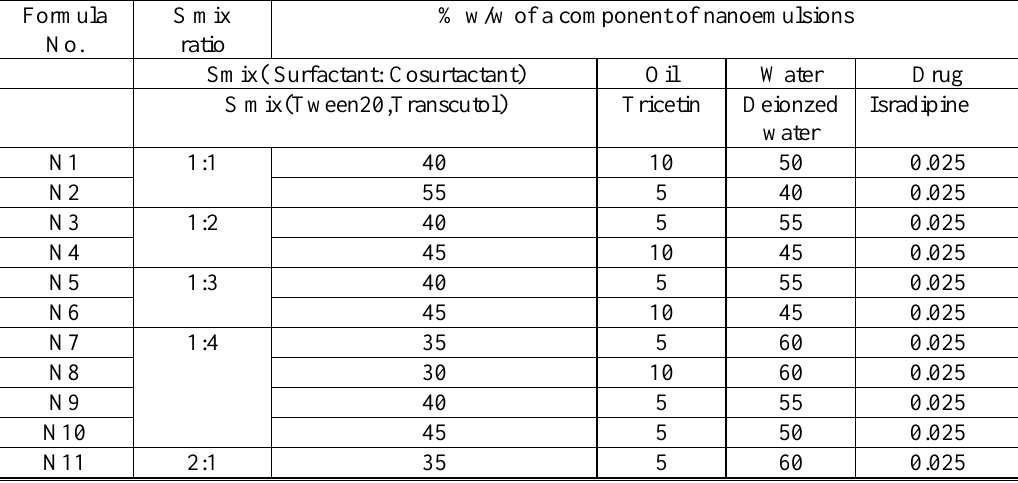
Table 3 . Formulation of different isradipine loaded nanoemulsion